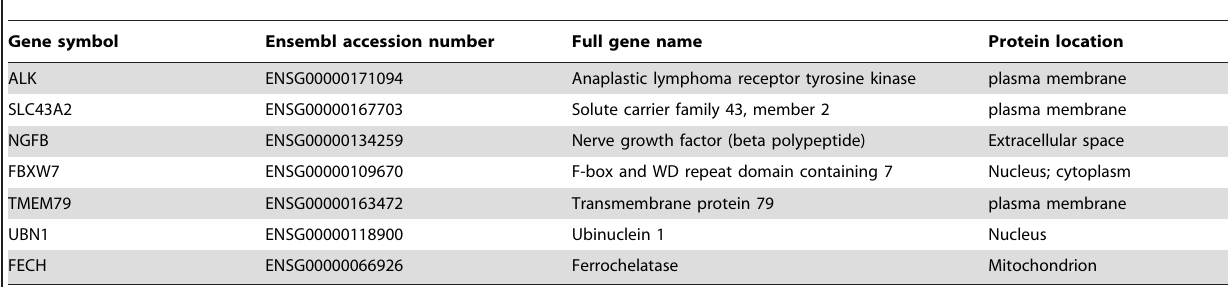
Table 4. ClaNC defined set of 7 discriminant genes for